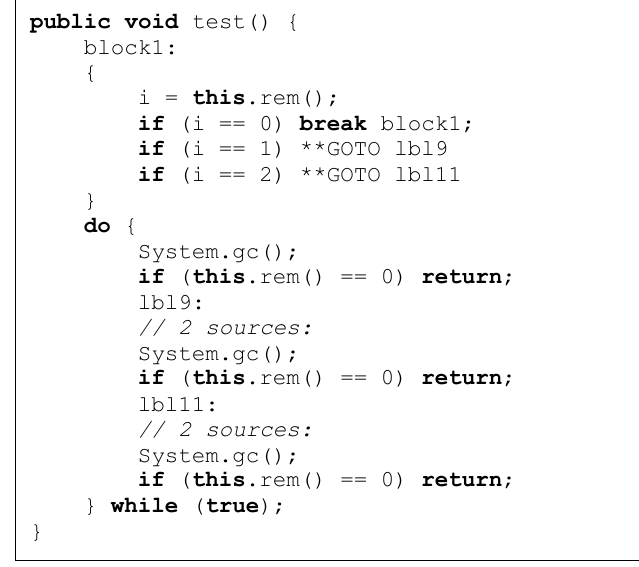
Fig. 15. CFR decompilation result.